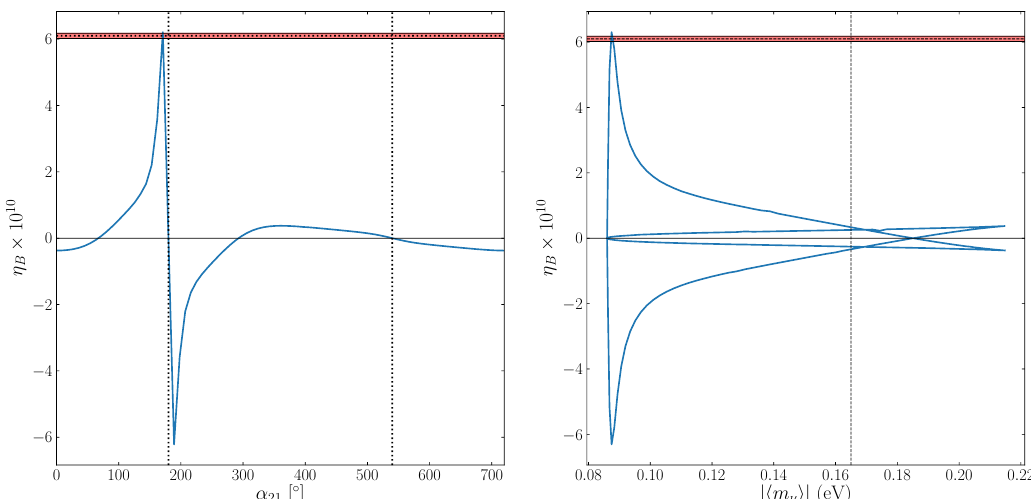
Figure 11 . Intermediate scale leptogenesis ( M 1 = 7 : 00 solely by (cid:11) 21 and with (cid:14) = (cid:11) 31 = 0. The red band indicates the 1 (cid:27) observed values for (cid:17) B with the best-(cid:12)t value indicated by the horizontal black dotted lines. Left: the baryon asymmetry against (cid:11) 21 with exact CP -invariance at (cid:11) 21 = 180 (cid:14) and 540 (cid:14) (vertical black dotted lines). Right: a parametric plot of (cid:17) B against the e(cid:11)ective neutrino mass dashed black line denoting the upper value of the KamLAND-Zen bound 0 : 165 eV [74].